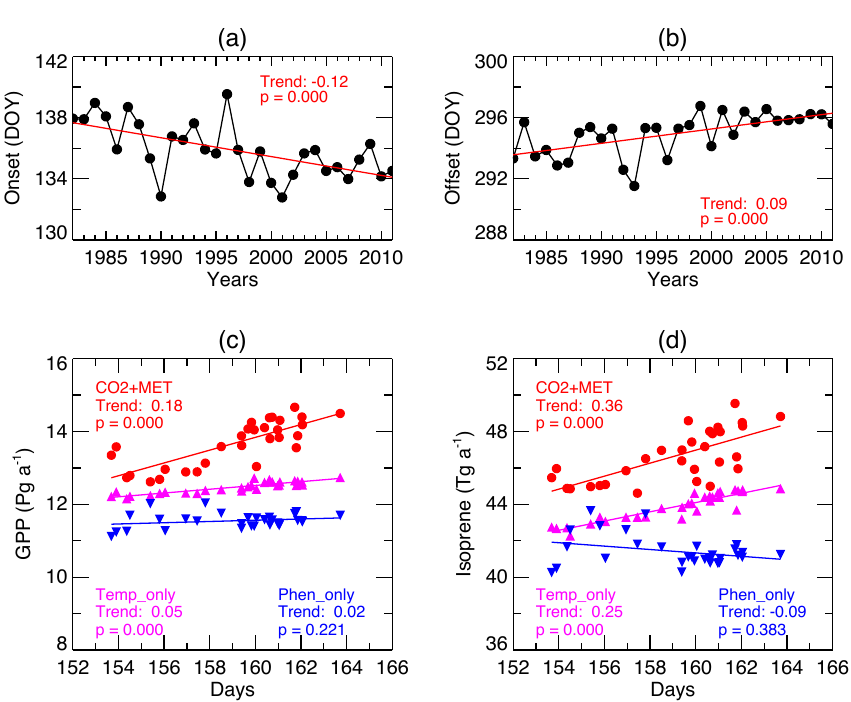
Figure 8. Predicted trend in (a) budburst and (b) dormancy onset dates over north of 30 ◦ N and the responses of (c) GPP and (d) isoprene emissions to the changes in the growing length. Both GPP and isoprene emissions are the sum of DBF, shrub, grassland, and tundra. Isoprene is simulated with the PS_BVOC scheme. For the bottom panel, different colors indicate sensitivity experiments with different year-to-year forcings: CO 2 and meteorology (red), temperature only (magenta), and phenology only (blue). Units of trends are (a) daya − 1 , (b) day a − 1